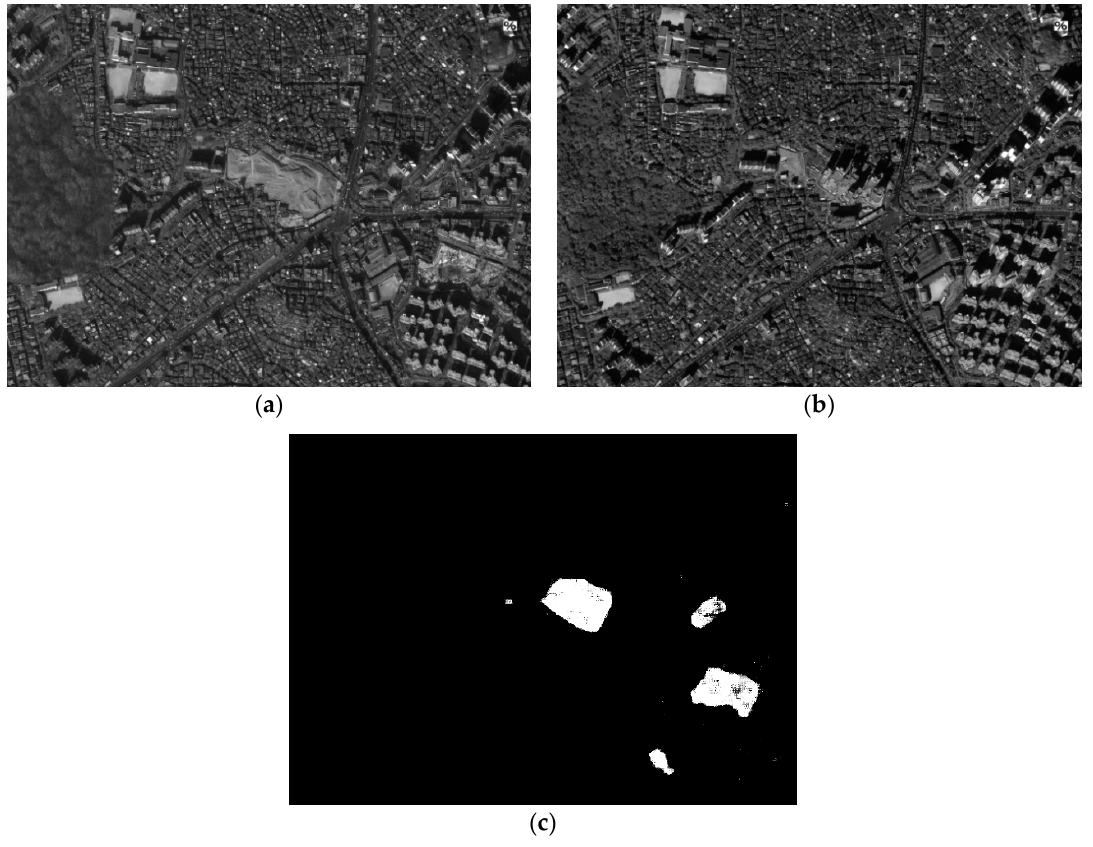
Figure 6. Training dataset: ( a ) Image acquired in March 2014, ( b ) image acquired in December 2015, and ( c ) the ground truth.